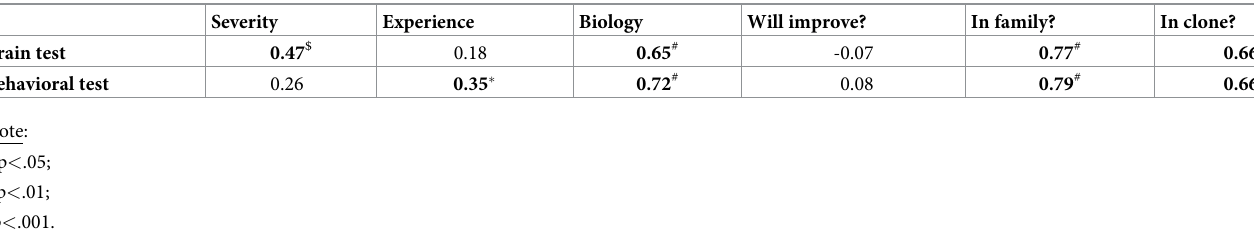
Table 1. Correlation between the perceived tendency of dyslexia to affect the brain and its perceived origins and